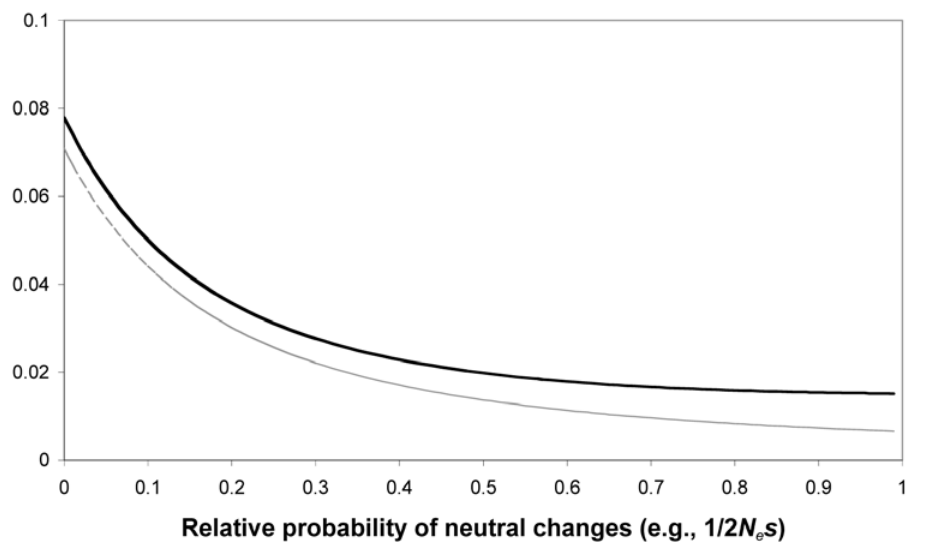
Figure 1. The influence of neutral changes on path repeatability. Path repeatability is shown as a function of the probability of neutral changes relative to beneficial mutations (which are assumed to have equal probability), which is roughly equal to 1/2 N e s in a haploid population. Results are shown both excluding (upper trace) and including (lower trace) back mutations.